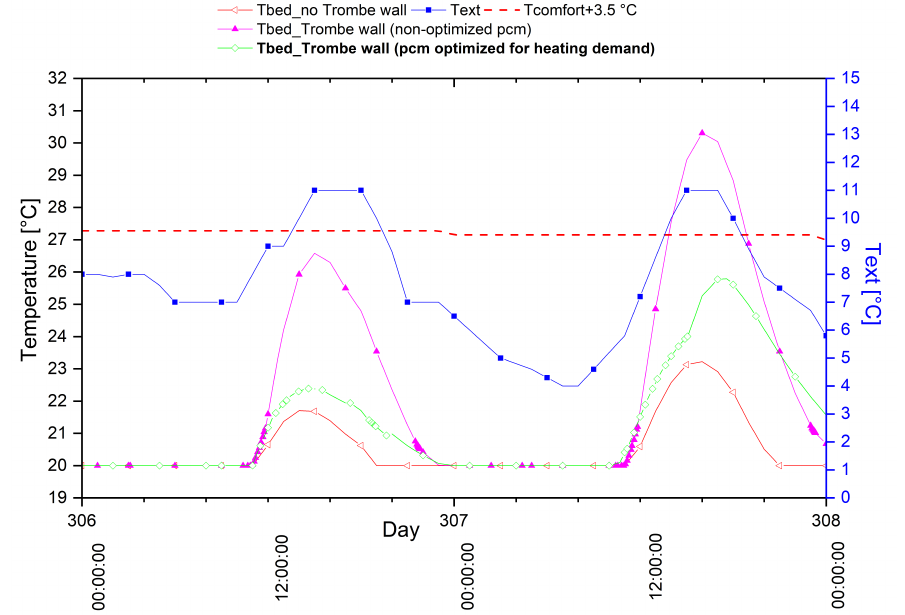
denote respectively the comfort+3.5 ◦ C